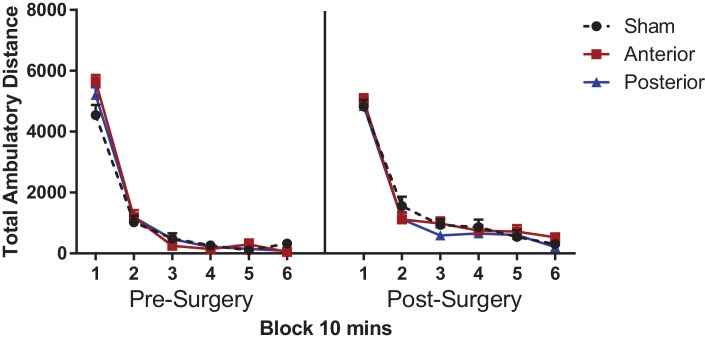
OFC lesions do not affect general locomotor activity.Mean number of beam breaks before (left) and after (right) surgery, in blocks of 10 mins. Error bars depict + SEM. A mixed Group x Surgery (Pre, Post) x Block (6 blocks of 10 mins) ANOVA revealed a significant main effect of Surgery (F(1, 41)=10.18, p=0.003), Block (F(5, 205)=659.29, p<0.001) and a Surgery x Block interaction (F(5, 205)=4.88, p<0.001, all remaining effects F < 1.71, p>0.08). The significant effect of surgery was a reduction in locomotor activity post-surgery which is likely to be a result of habituation to the locomotor chamber.